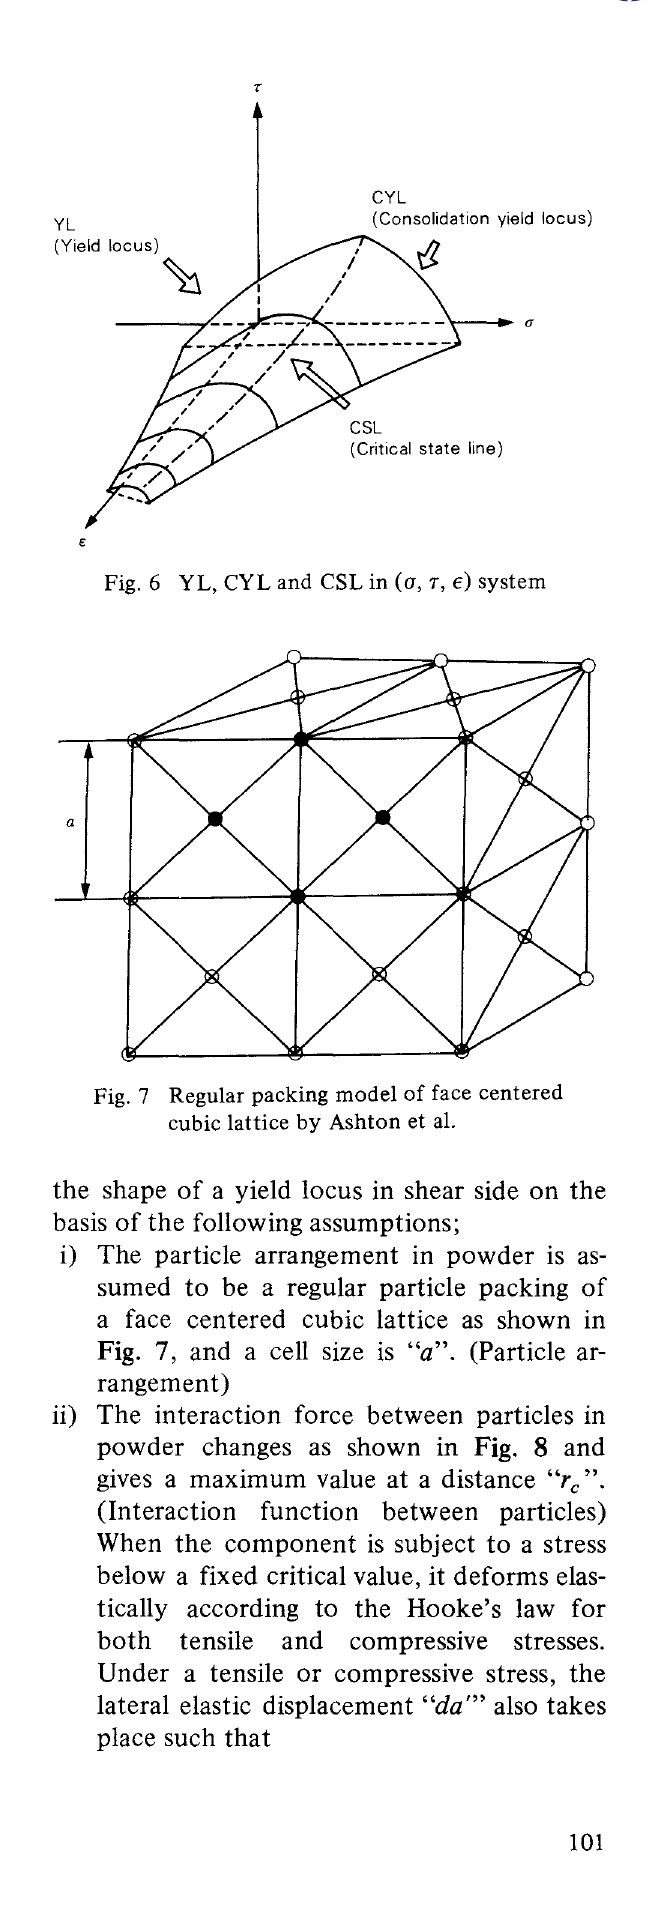
Fig. 5 Actual fracture surface and ideal fracture surface of an aggregated particle (Rumpf)